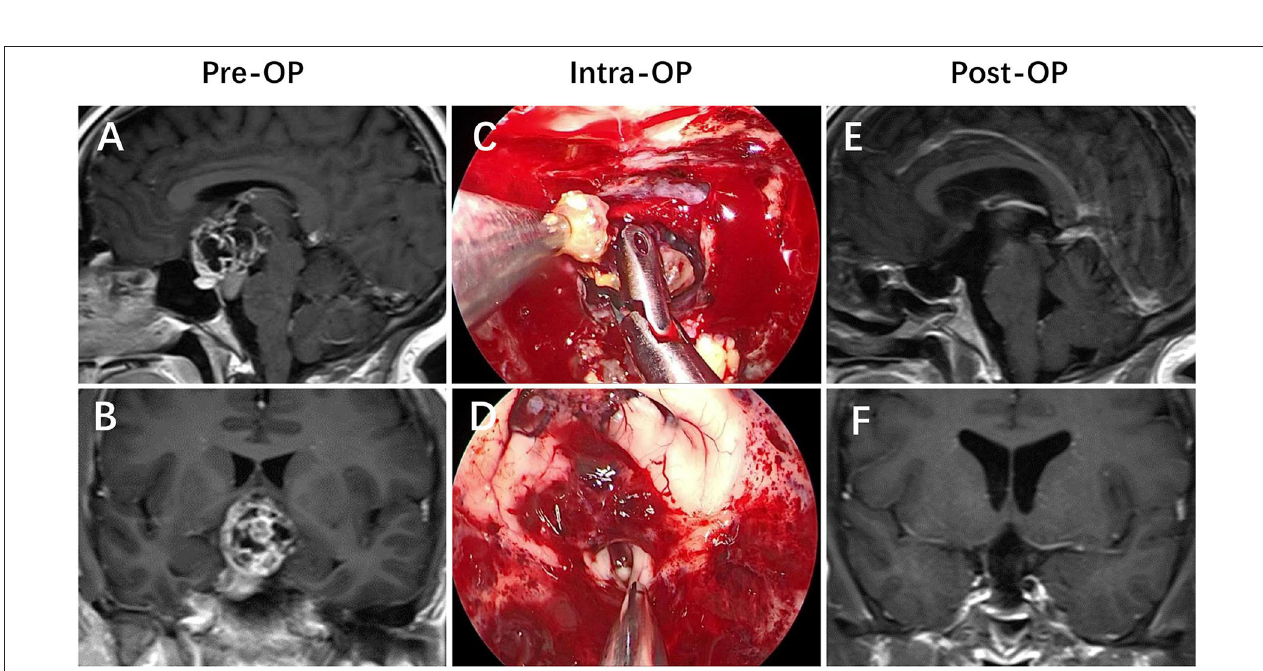
FIGURE 3 | Craniopharyngioma with hypothalamic invasion. (A,B) Preoperative enhanced MRI demonstrated that an extraintraventricular mass developed from the pituitary gland and/or the pituitary stalk that had invaded the third ventricle after breaking through the third ventricle floor. (C,D) Intraoperative views revealed that the patient achieved a gross-total resection of the lesion via the endonasal endoscopic endonasal infrachiasmatic corridor. (E,F) Postoperative enhanced MRI revealed that the lesion was totally removed, with the TVF opened.